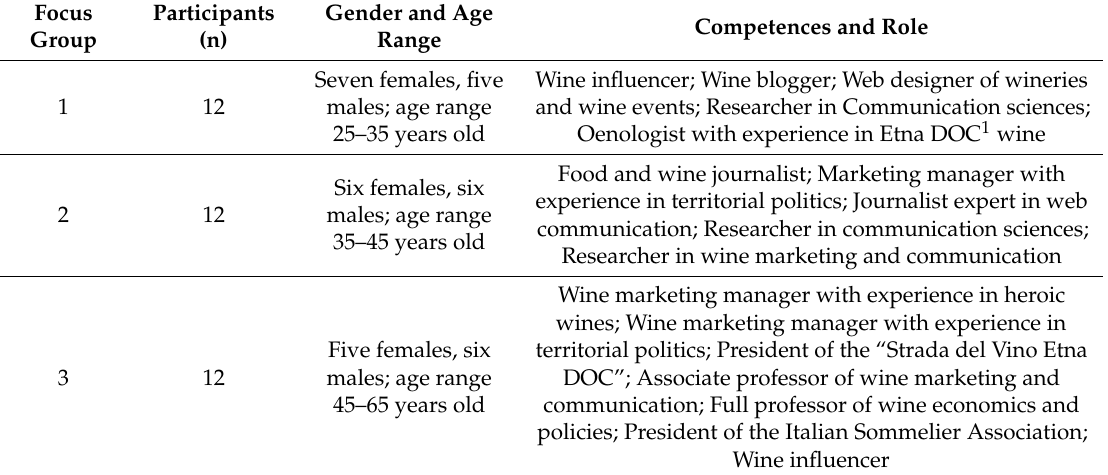
Table 1. Composition of focus groups, and sociodemographic characteristics of